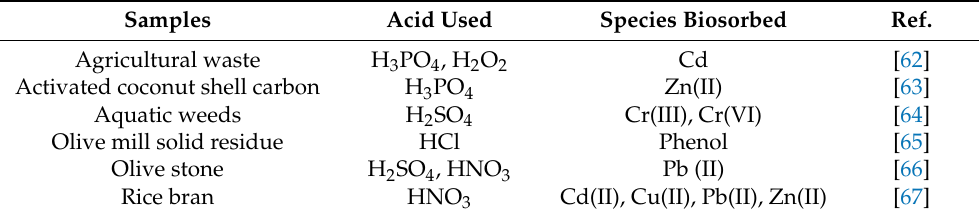
Table 2. Some reports on the alteration of AC with acid